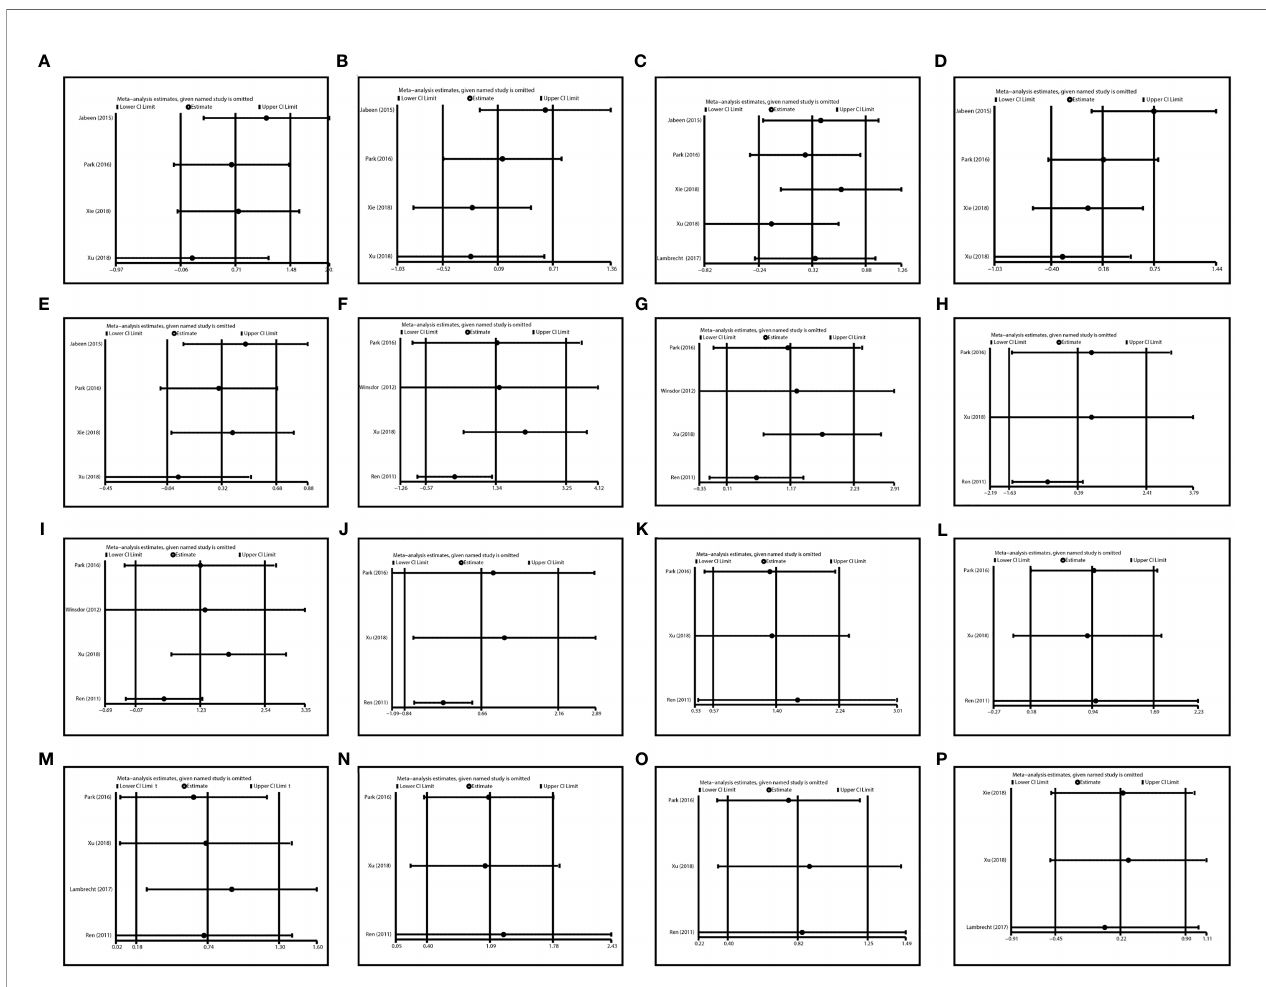
FIGURE 6 | Sensitivity analysis in various comparisons. (A) TT vs CC in liver toxicity; (B) TC vs CC in liver toxicity; (C) TT vs. TC/CC in liver toxicity; (D) TT/TC vs. CC in liver toxicity; (E) T vs C in liver toxicity; (F) TT vs CC in kidney toxicity; (G) TC vs CC in kidney toxicity; (H) TT vs. TC/CC in kidney toxicity; (I) TT/TC vs. CC in kidney toxicity; (J) T vs. C in kidney toxicity; (K) TT vs CC in Mucositis; (L) TC vs CC in Mucositis; (M) TT vs. TC/CC in Mucositis; (N) TT/TC vs. CC in Mucositis; (O) T vs. C in Mucositis; (P) TT vs. TC/CC in